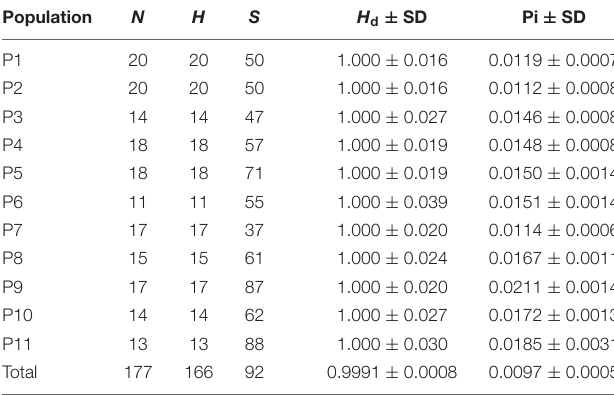
TABLE 3 | Parameters of genetic diversity in populations of Aphis aurantii . Population